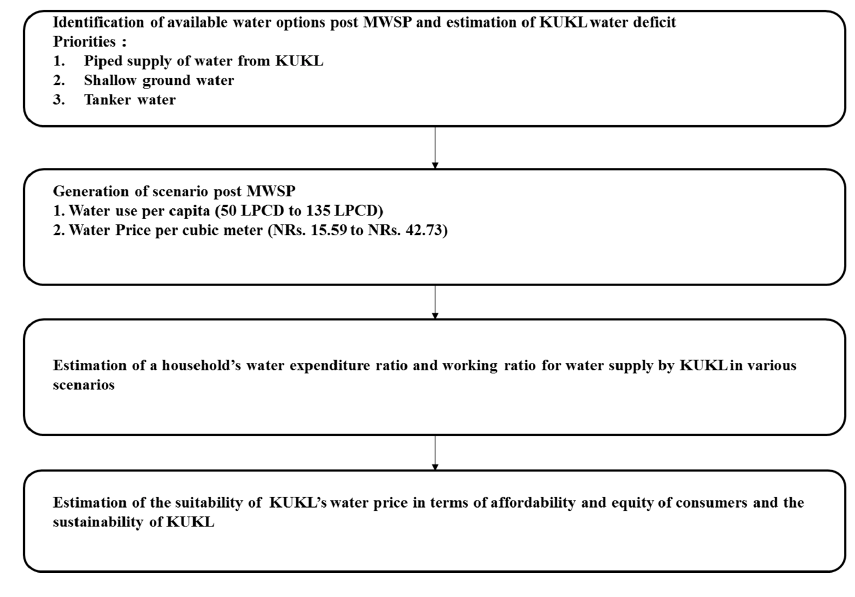
Figure 2. Methodological framework.